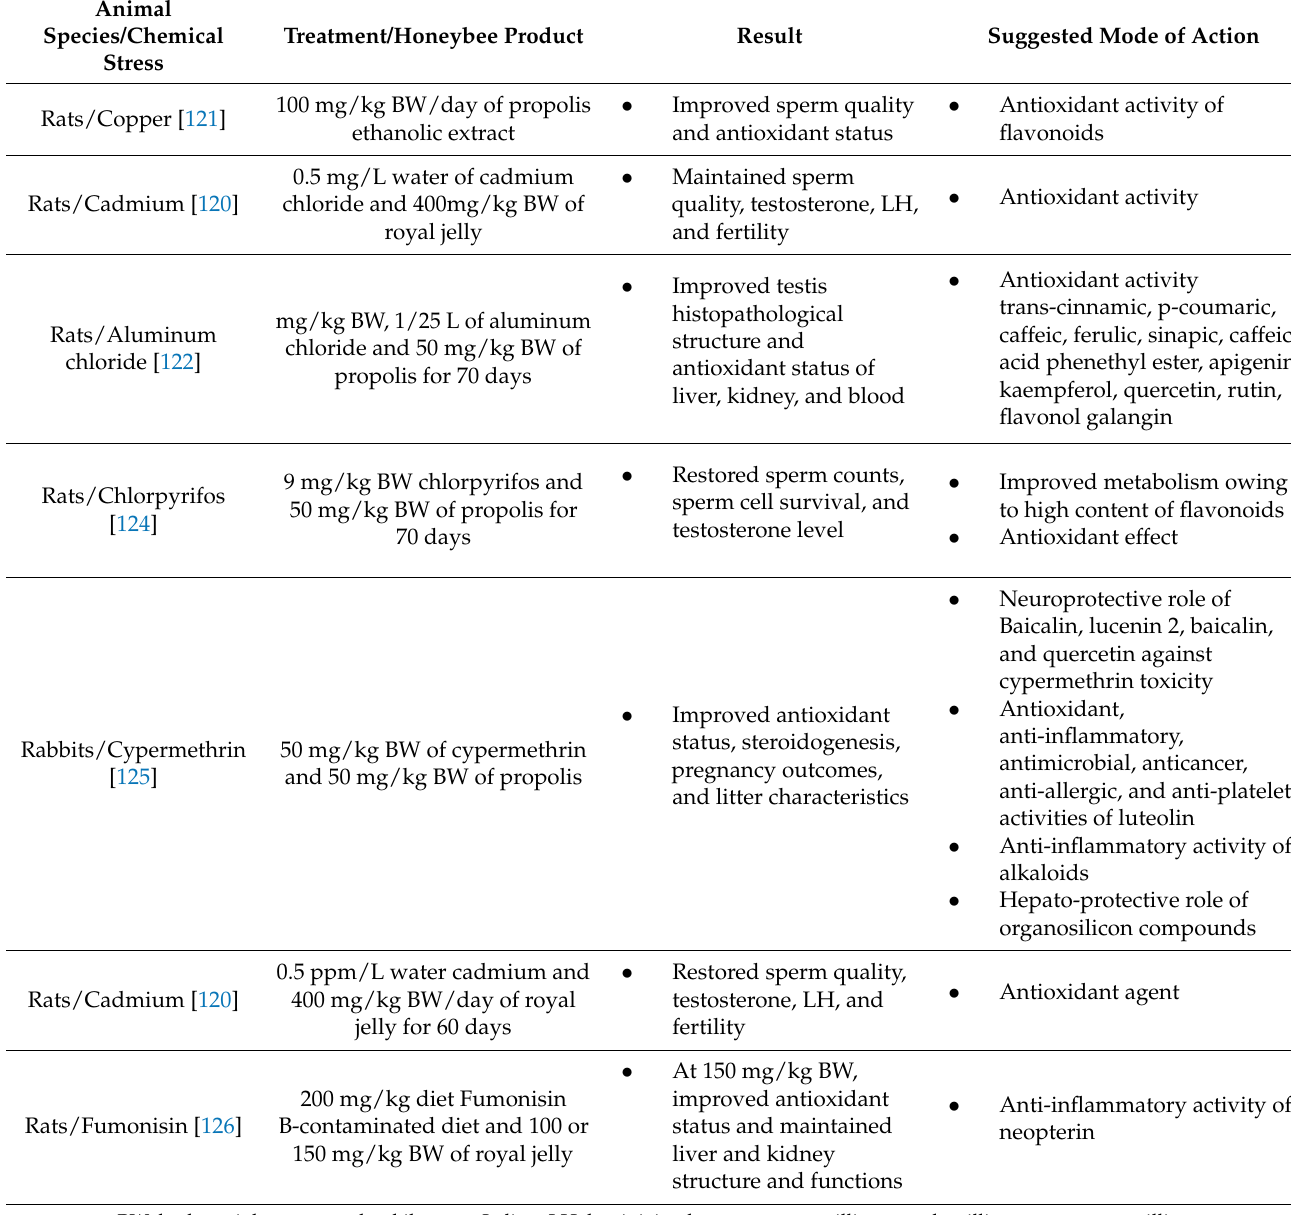
Table 7. Protective effects of honeybee products against chemical stresses-induced reproductive toxicity in